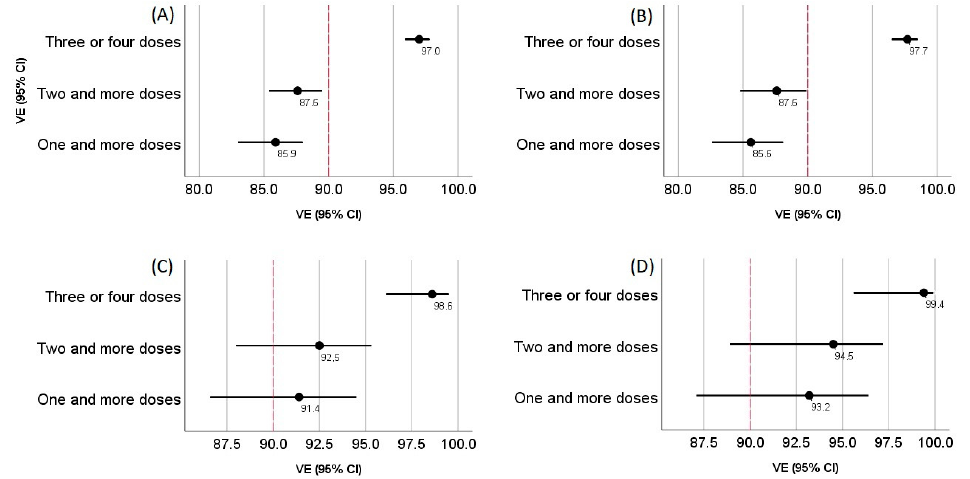
Figure 2. Levels of IgG antibodies in the RBD domain and NC protein depending on severity. Two groups are presented—unvaccinated and vaccinated with two components of Sputnik V. The Y-axis indicates the number of antibodies (PC), and shows the median, upper, and lower quantiles. The unvaccinated samples are characterized by a wide variation in the level of IgG antibodies in the RBD domain of the S protein. ( A )—shows the level of antibodies IgG RBD in unvaccinated patients, ( B )—the level of IgG NC in unvaccinated patients, ( C )—the level of IgG RBD in vaccinated patient and ( D )—the level of IgG NC in vaccinated patients.